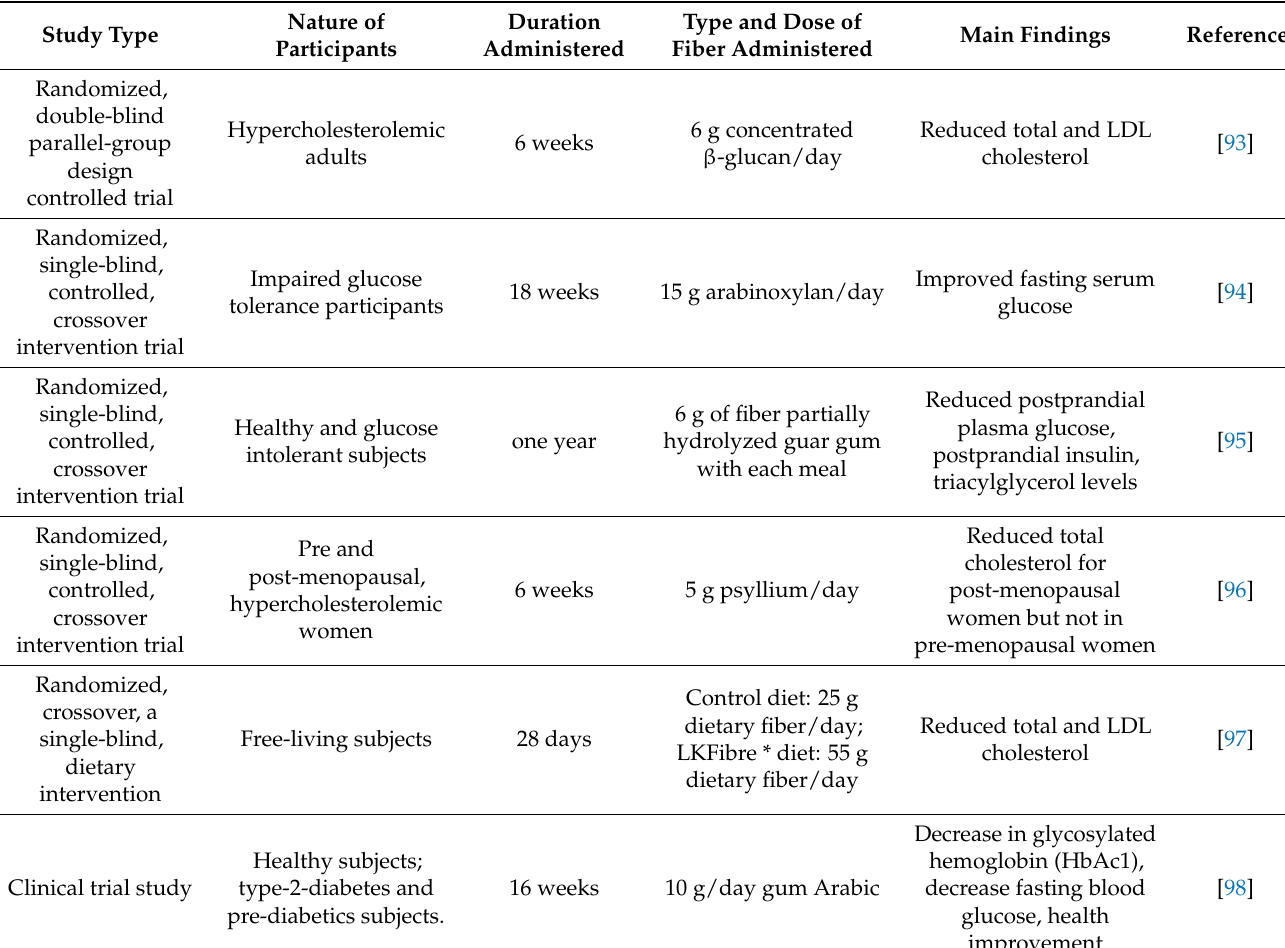
Table 2. Studies reporting fiber administration in